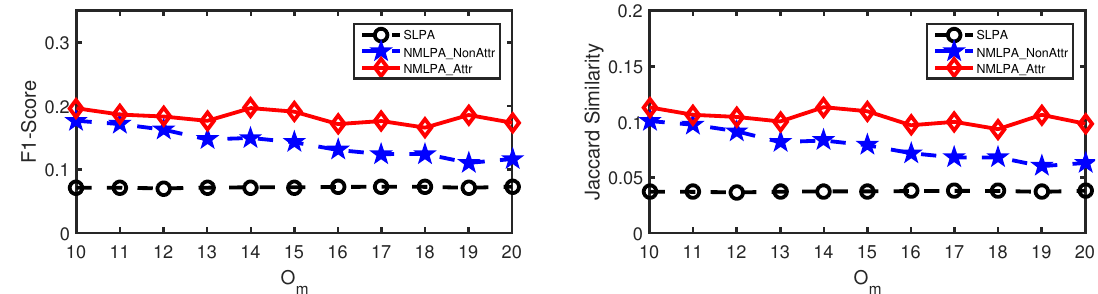
Figure 6. Performance comparison (in terms of F1-score and Jaccard Similarity, respectively) on synthetic networks with µ =